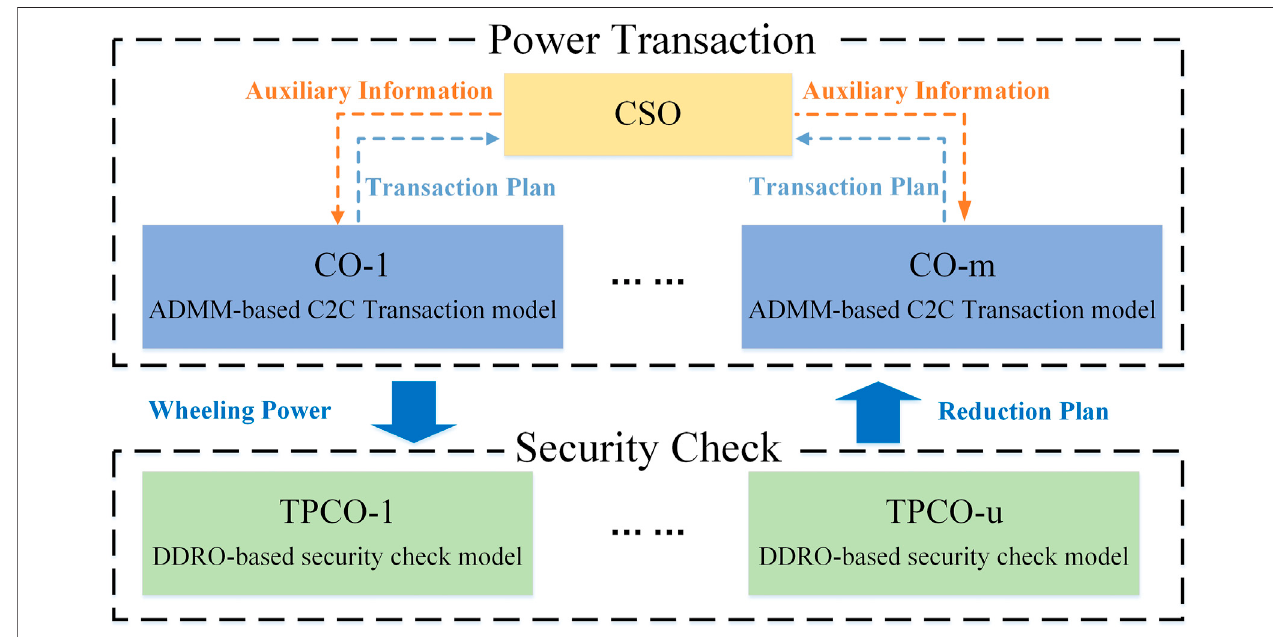
FIGURE 1 | Iterative process of distributed economic